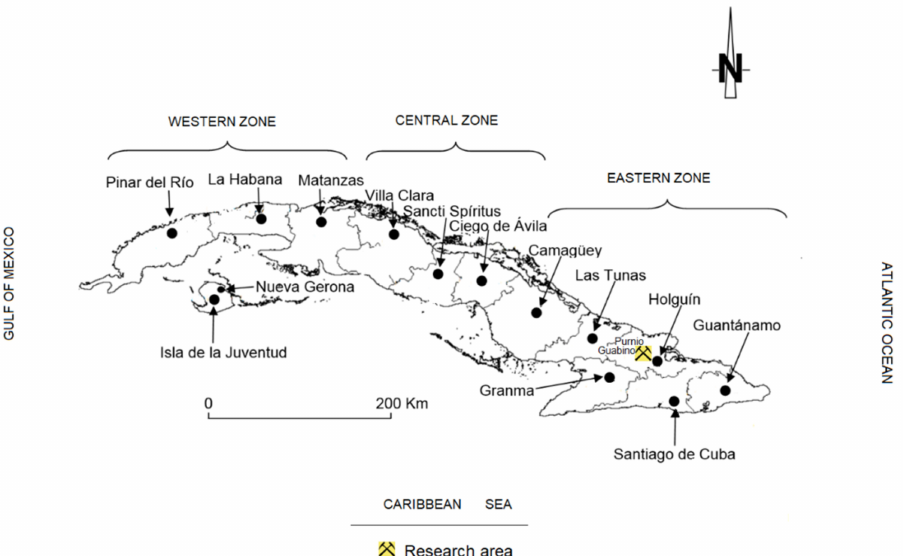
Figure 1. Location of the area of